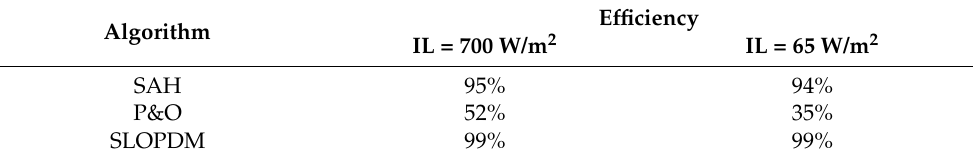
Table 7. The comparison of proposed SLOPDM, SAH, and P&O algorithms under